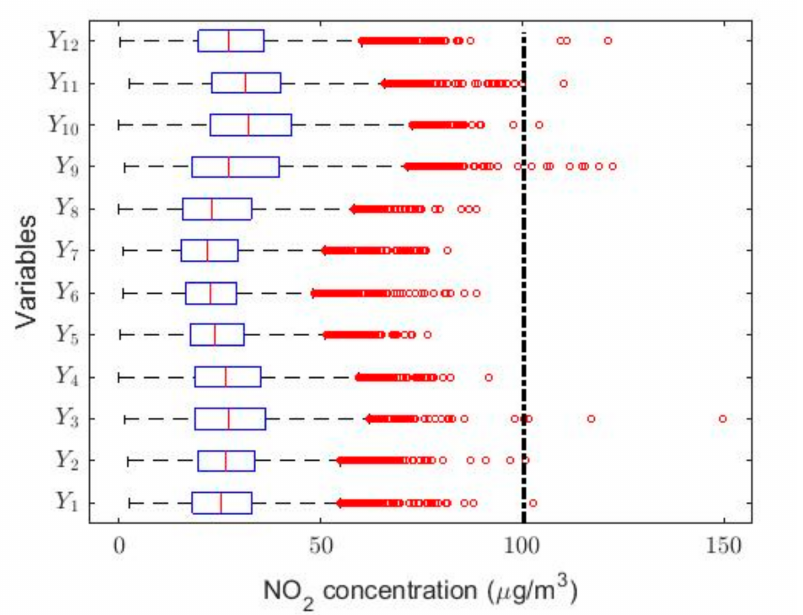
Figure 5. Box plot of data: Y 1 (January), Y 2 (February), Y 3 (March), Y 4 (April), Y 5 (May), Y 6 (June), Y 7 (July), Y 8 (August), Y 9 (September), Y 10 (October), Y 11 (November), and Y 12